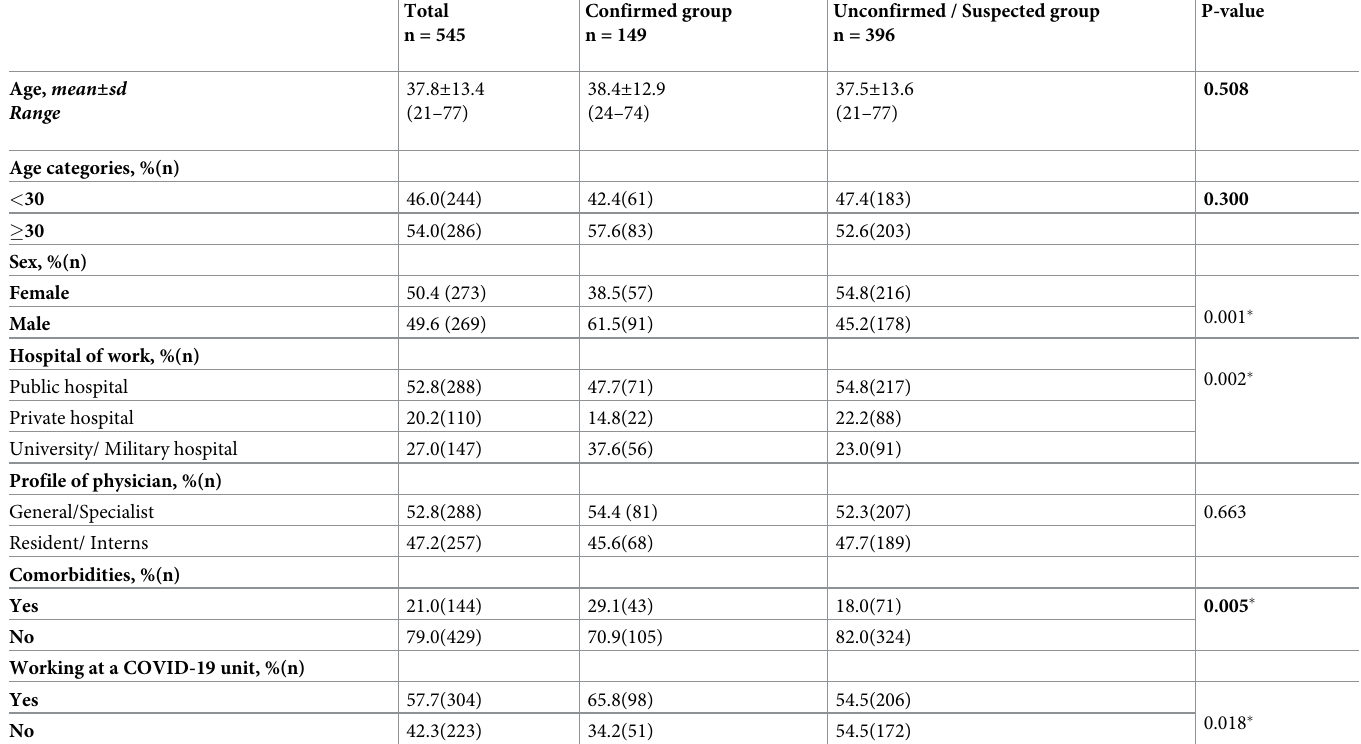
Table 1. Association between sociodemographic and clinical data with the infection of physicians with